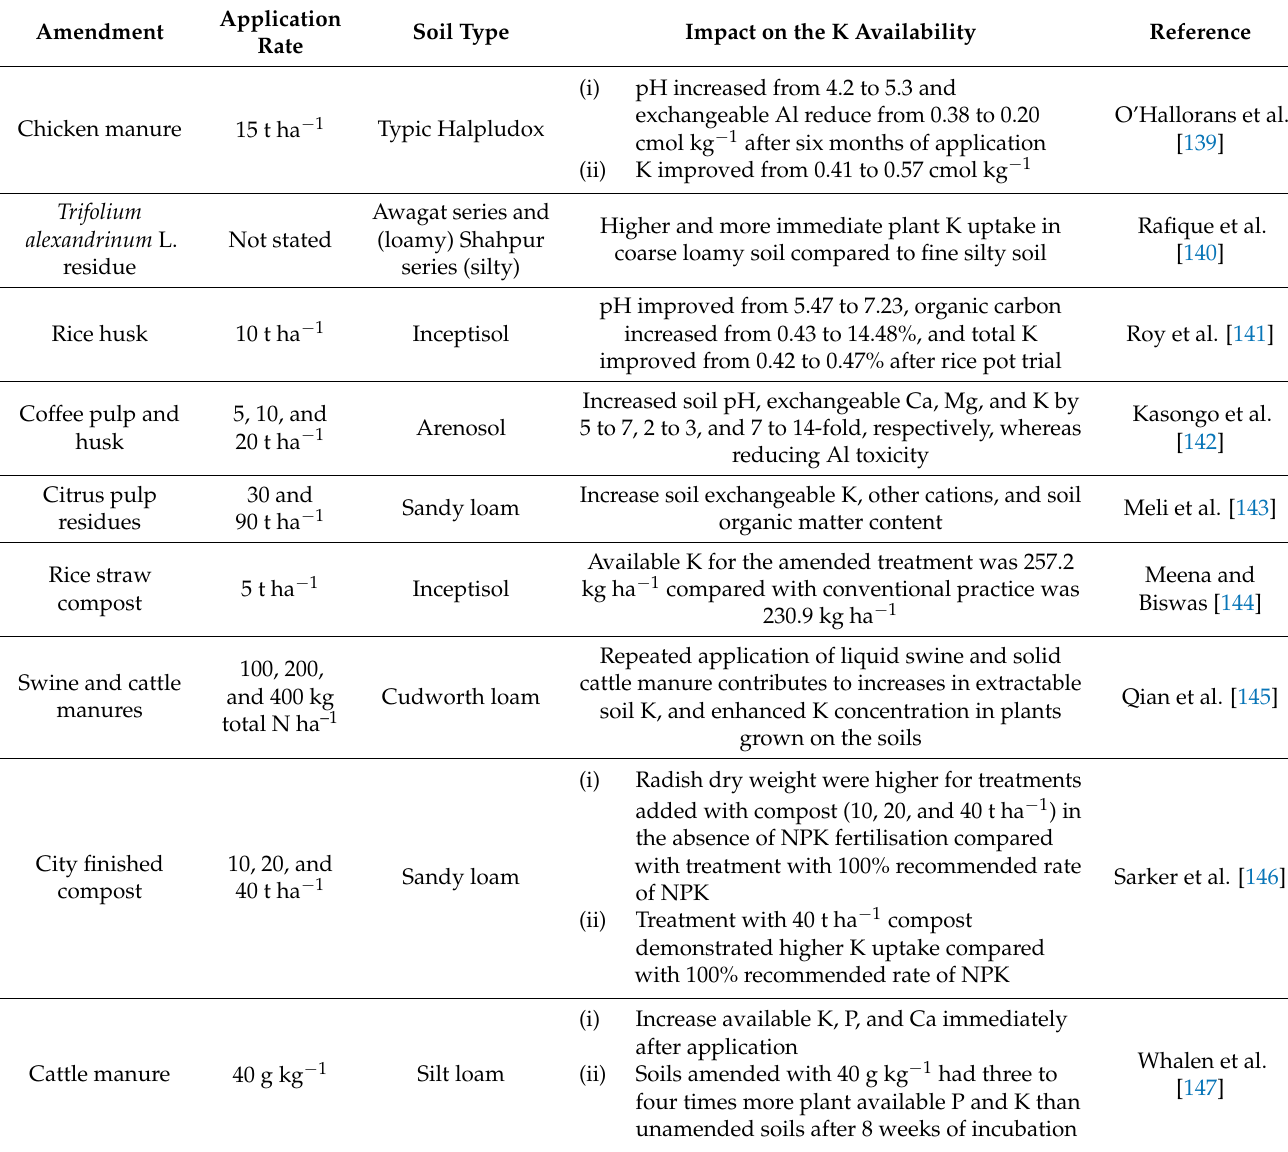
Table 1. Organic amendments application on the physicochemical properties of acid